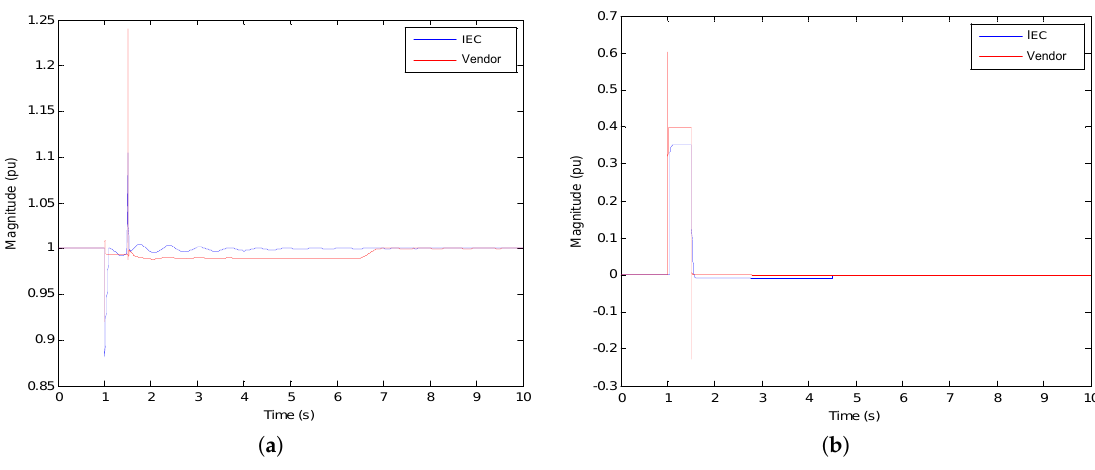
Figure 8. Type IIIB results. Simulation scenario: p = 1.0 pu, u = 0.85 pu, t = 500 ms, w s = 1.1. ( a ) Active power, p ; and ( b ) reactive current, i q